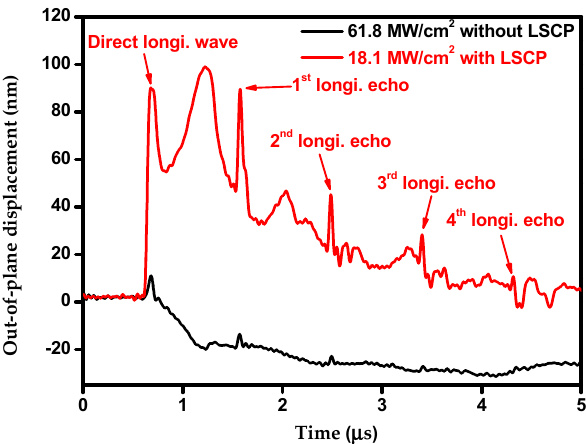
Figure 3. Signals with and without application of the liquid-suspended carbon particles (LSCP) layer for optoacoustic conversion at the same generation point.